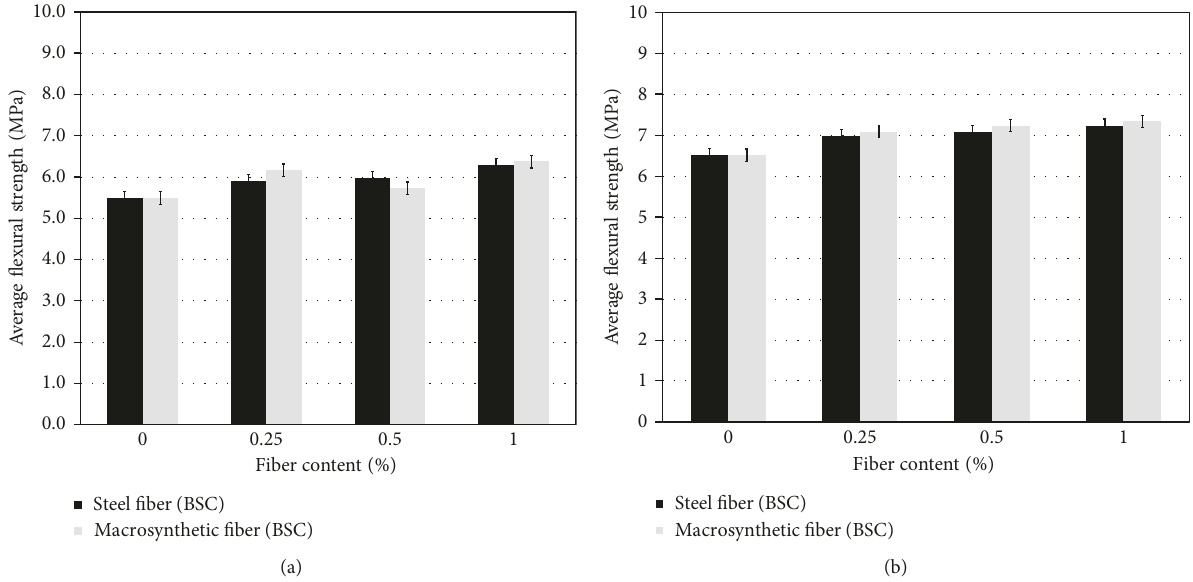
Figure 12: Flexural strength of BSC segments with reinforcing types. (a) Target strength 40 MPa. (b) Target strength 60